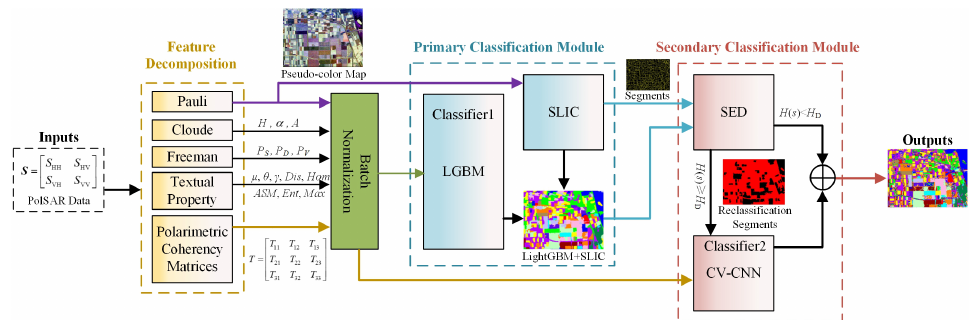
Figure 1. Schematic diagram of the proposed